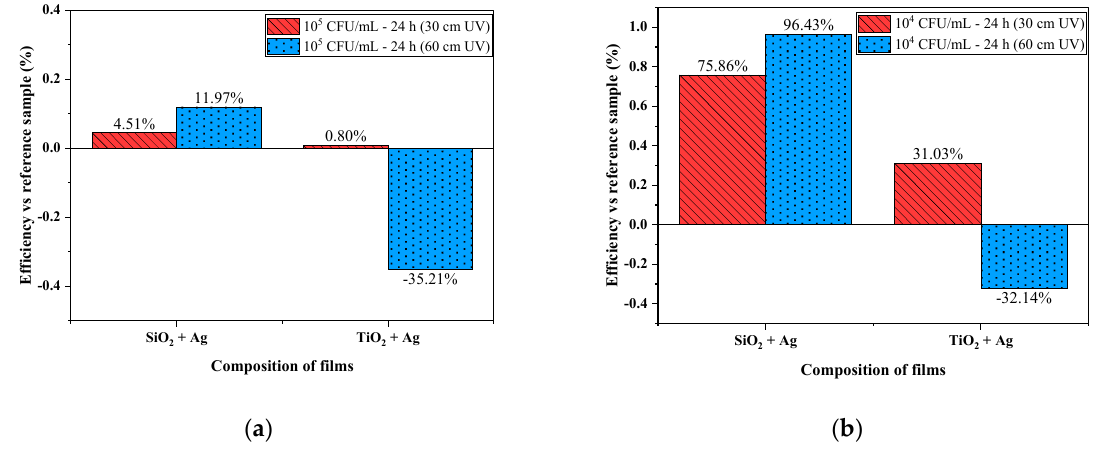
Figure 5. Antibacterial efficacy of UV-treated coatings (30 and 60 cm) for activation at different concentrations of Escherichia coli inoculum: 10 5 CFU/mL ( a ) and 10 4 CFU/mL ( b ).